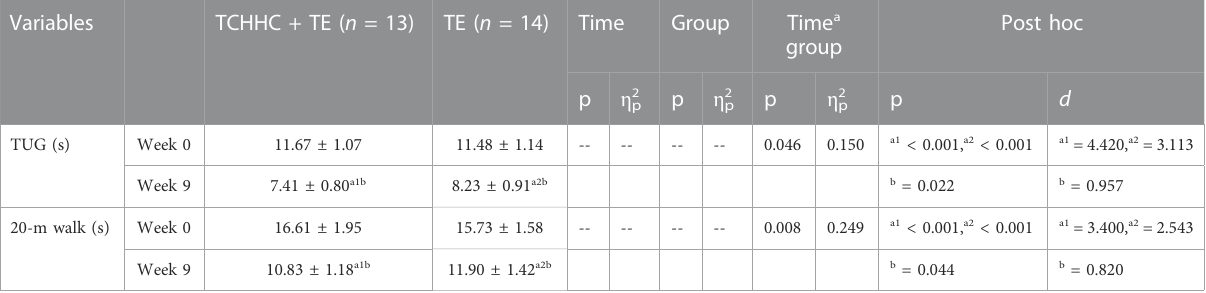
TABLE 5 The times of TUG and 20-m walk tests at weeks 0 and 9.